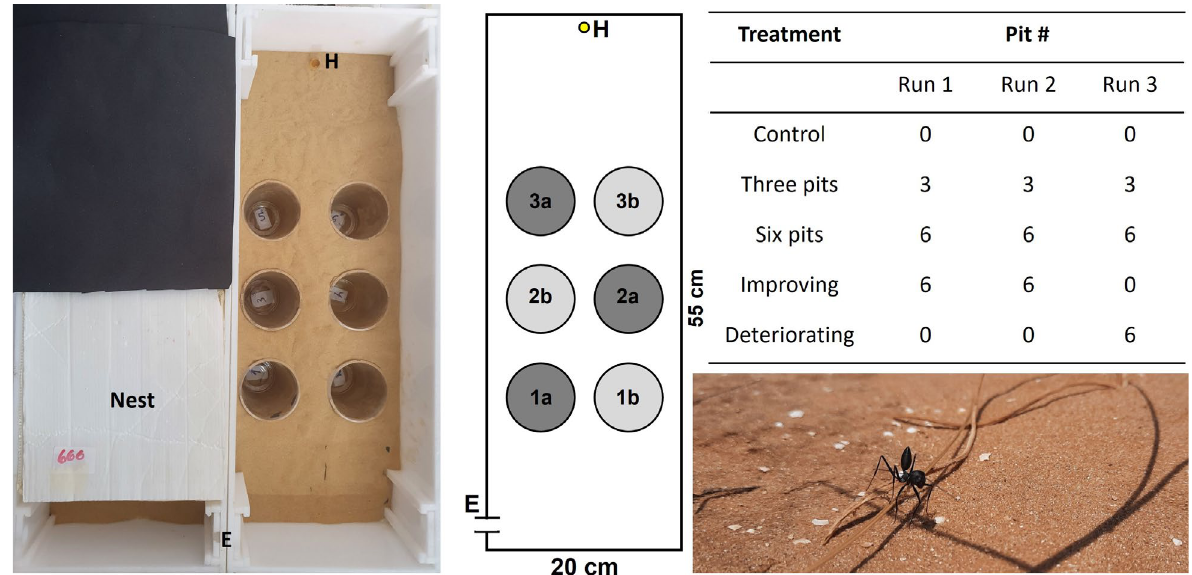
Figure 1. Left: A photo and a scheme of the test arena. The two horizontally parallel lines (E) stand for the entry to the arena from the nest. The small yellow circle (H) stands for the food reward (0.5 g honey). The large grey circles (1a,b, 2a,b, and 3a,b) stand for the six pits. In the three-pit treatment only 1a, 2a, and 3a were deployed in a zigzag arrangement, and the other pits were covered with sand. Right: The five treatments applied in the two experiments and the number (#) of pits in each of the three experimental runs. Lower right corner: A C. niger worker in its natural habitat.